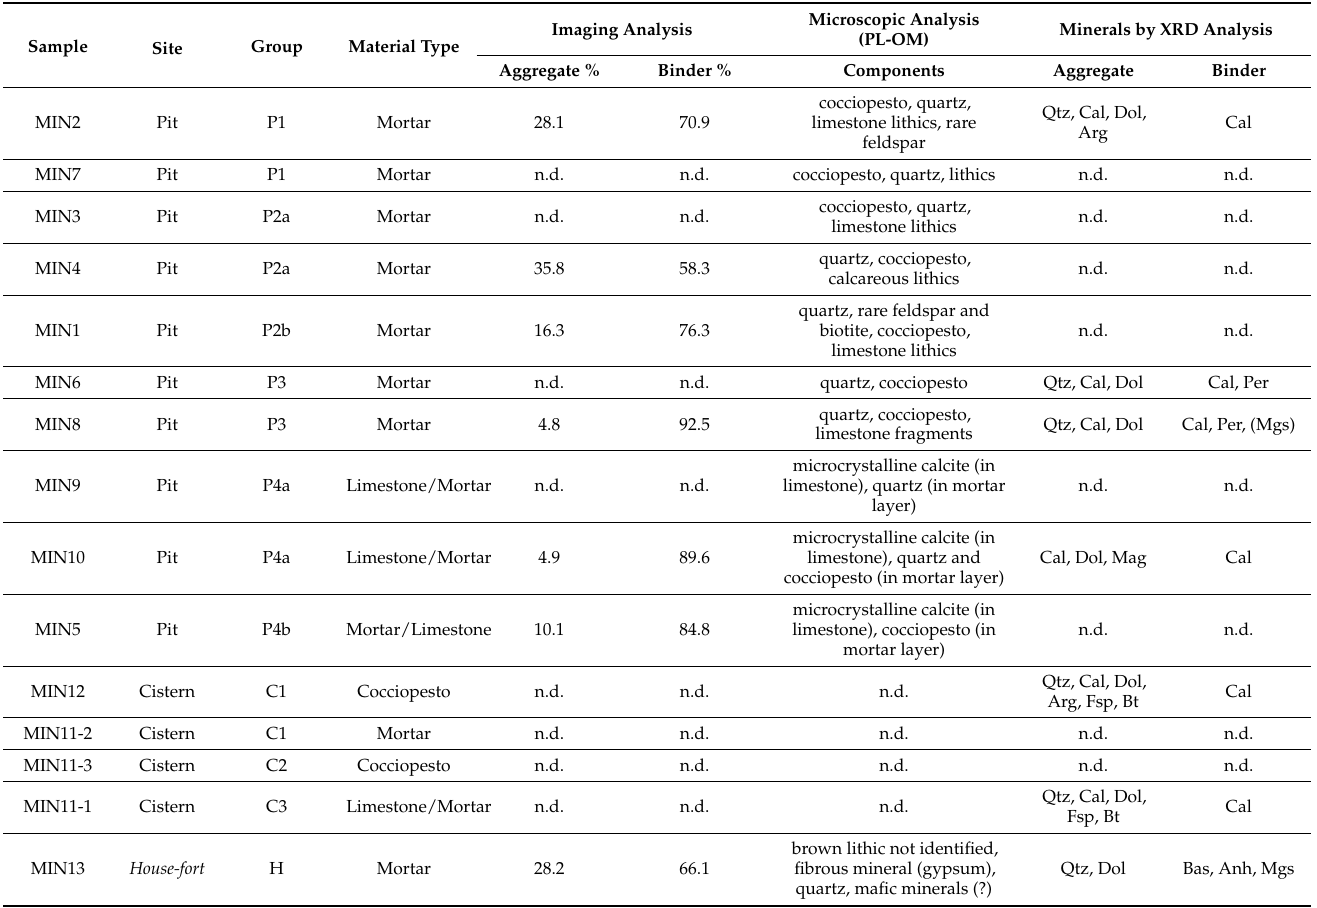
Table 2. Results of microscopic (PL-OM) and X-ray diffractometric (XRD) analysis of the samples taken from the pit and a stratigraphic layer up to the cyclopic construction area, from the cistern and from the house-fort of the archaeological site of Cap de